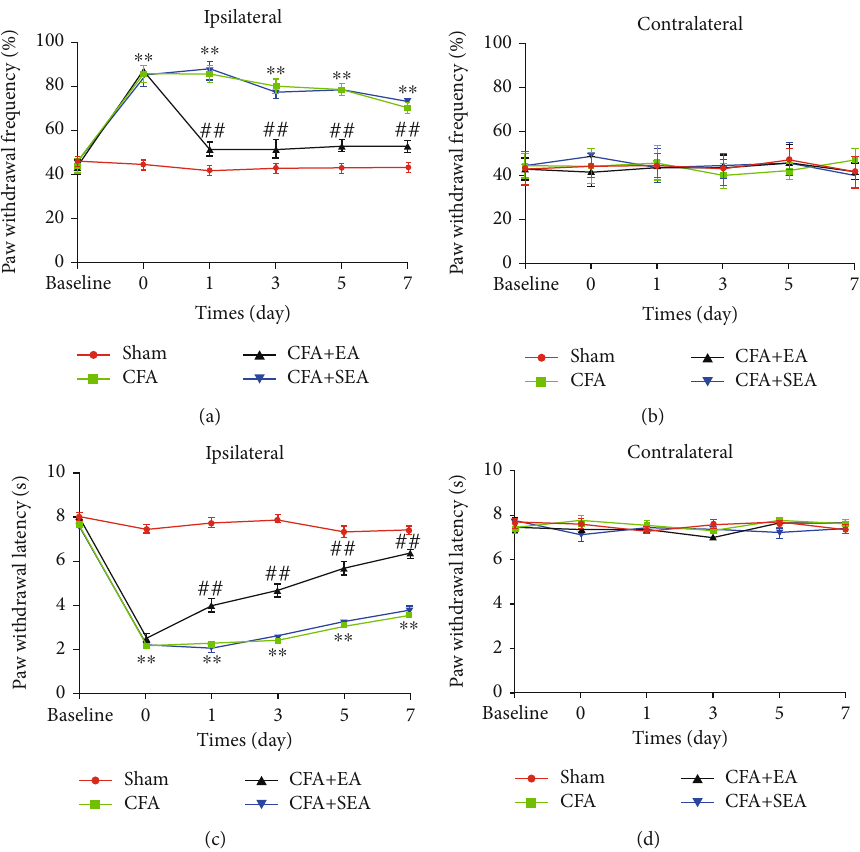
Figure 1: E ff ects of EA on CFA-induced mechanical and thermal pain threshold ( n = 7 /group). The paw withdrawal threshold was tested at base, 1 day, 3 days, 5 days, and 7 days after CFA injection. (a) The paw withdrawal frequency of the CFA group was increase, compared with the Sham group on the ipsilateral side. EA stimulation signi fi cantly decreased the paw withdrawal frequency. Sham EA has no e ff ect on paw withdrawal frequency. (c) The paw withdrawal latency of the CFA group was increased, compared with the Sham group on the ipsilateral side. EA stimulation signi fi cantly increased the paw withdrawal latency. Sham EA has no e ff ect on paw withdrawal latency. (b, d) No di ff erence among the 4 groups on the contralateral side. ∗ P < 0 : 05 , ∗∗ P < 0 : 01 vs. sham group; # P < 0 : 05 , ## P < 0 : 01 vs. CFA